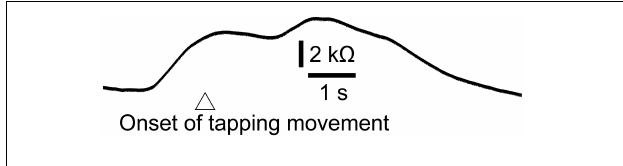
FIGURE 7 | Averaged trace of the EDR induced by the finger-tapping movement across 10 trials in a participant.